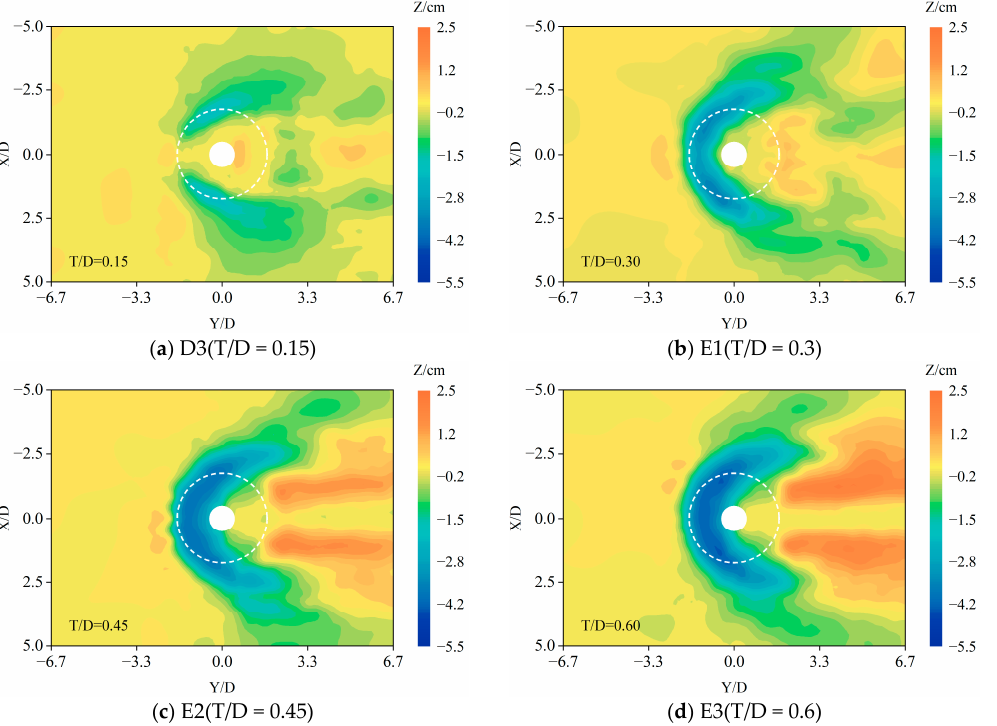
Figure 16. Local scour around the pier using the permeable collar with different thicknesses. Table 5. Maximum local scour depth around the pier using a permeable collar with different thicknesses.